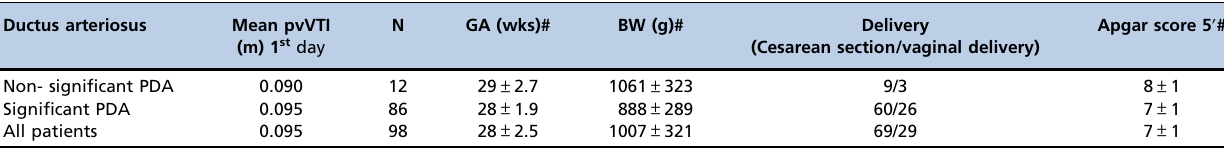
Table 1 - Clinical characteristics of enrolled infants in day 1.